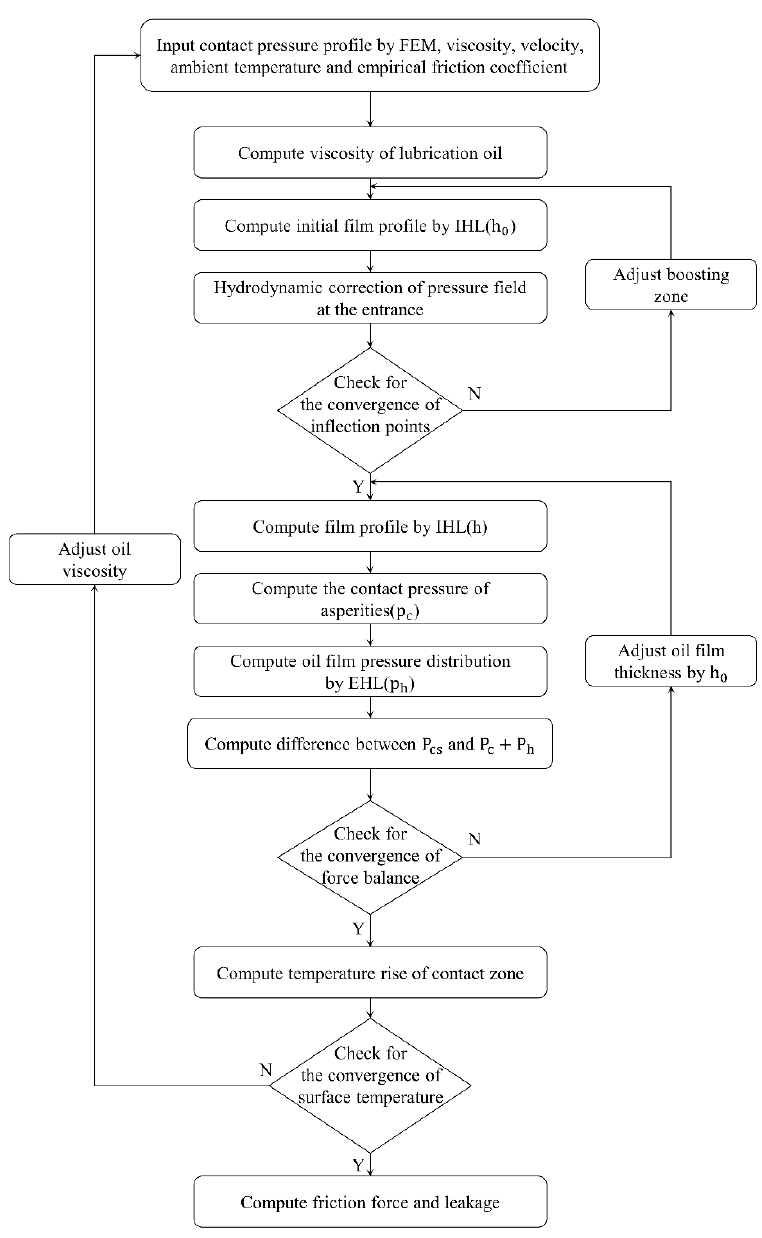
Figure 4. Flowchart of thermal mixed IHL .